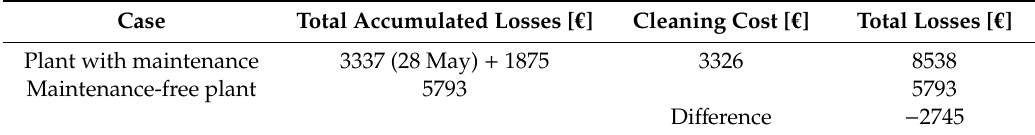
Table 8. Economic losses for the 1 MWp plant for the two proposed